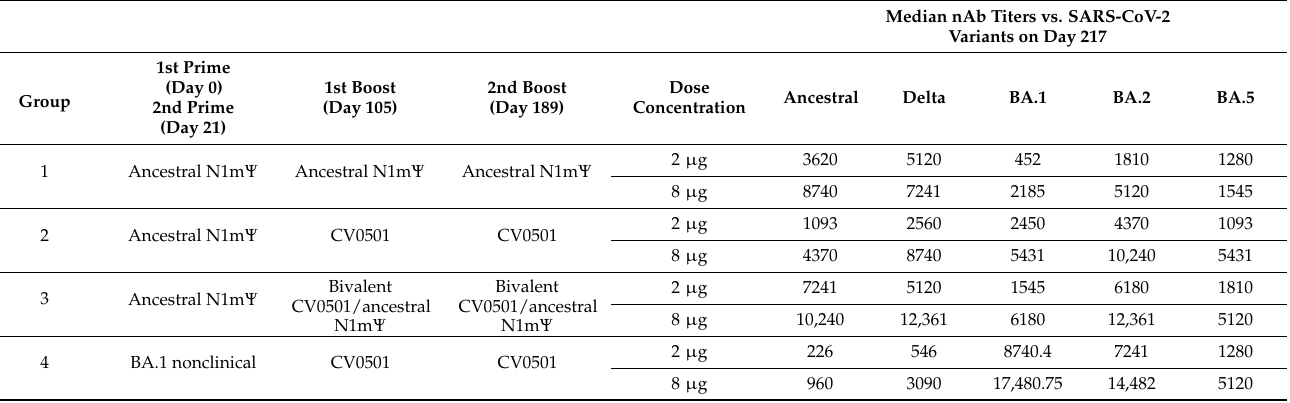
Ancestral N1m Ψ